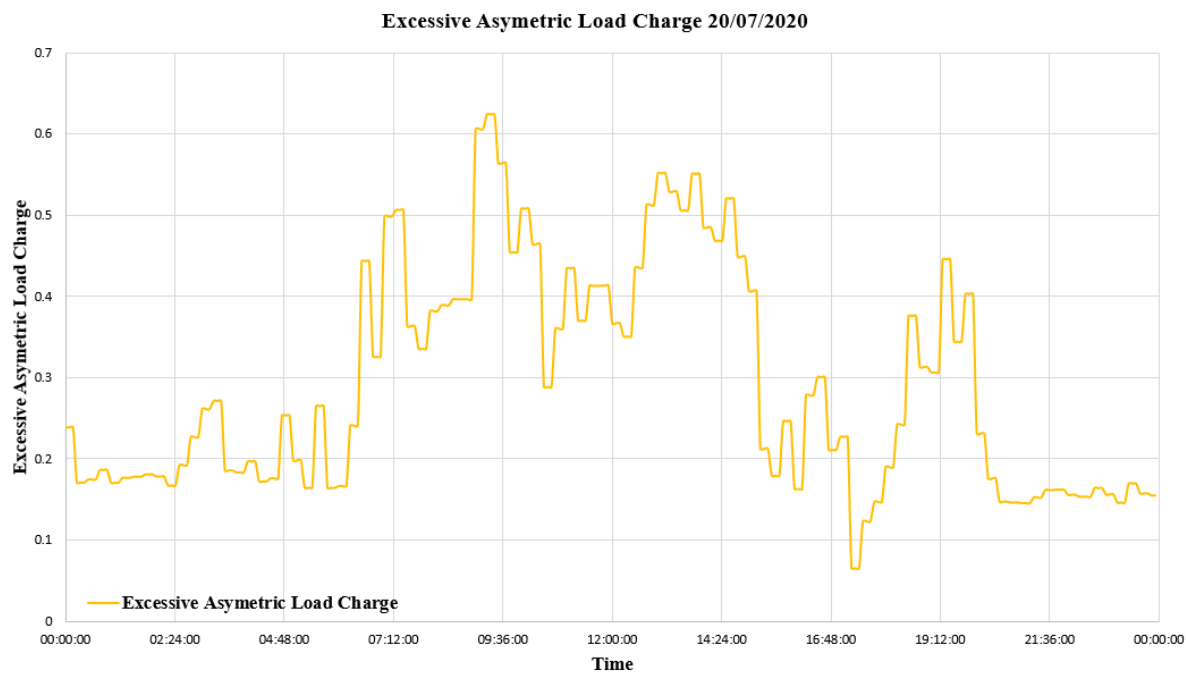
Figure 30. Load change observed within the MCAST micro-grid during a typical weekday.